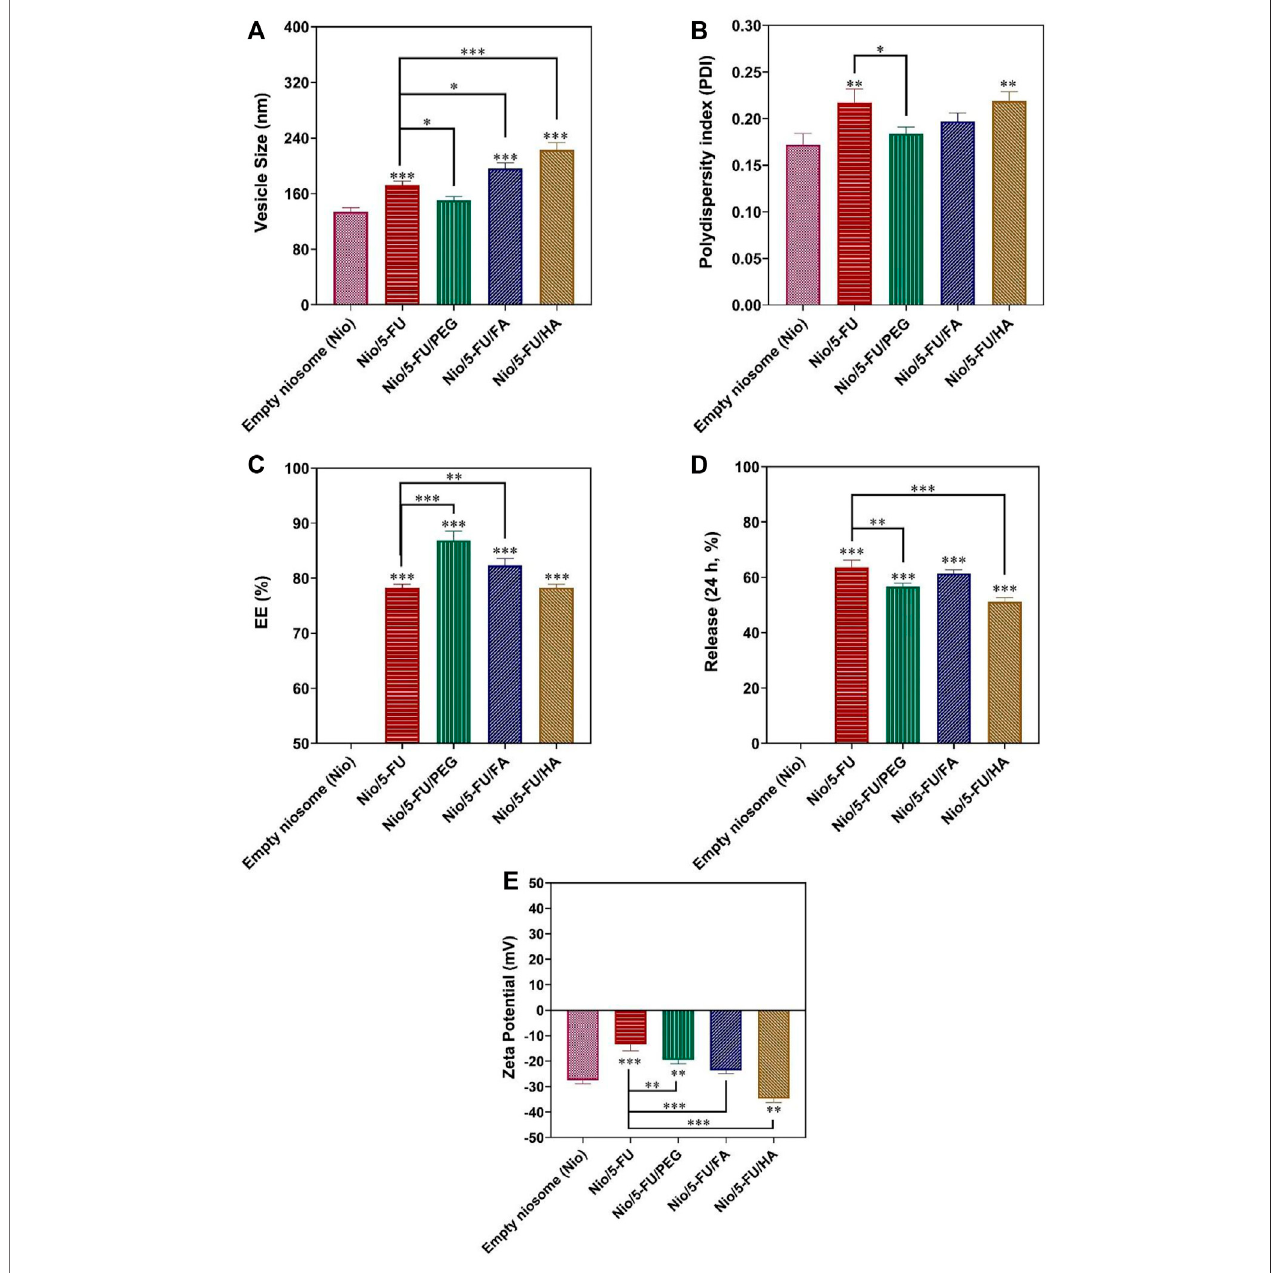
FIGURE 3 | Optimized responses were obtained by coated and uncoated formulations under the optimal conditions. (A) Vesicle size. (B) Polydispersity. (C) Entrapmentef fi cacy. (D) Releasepercentage. (E) ZetaPotential.Datarepresentmeans±standarddeviations( n =3).Forallcharts,***: p < 0.001;**: p < 0.01;*: p < 0.05.